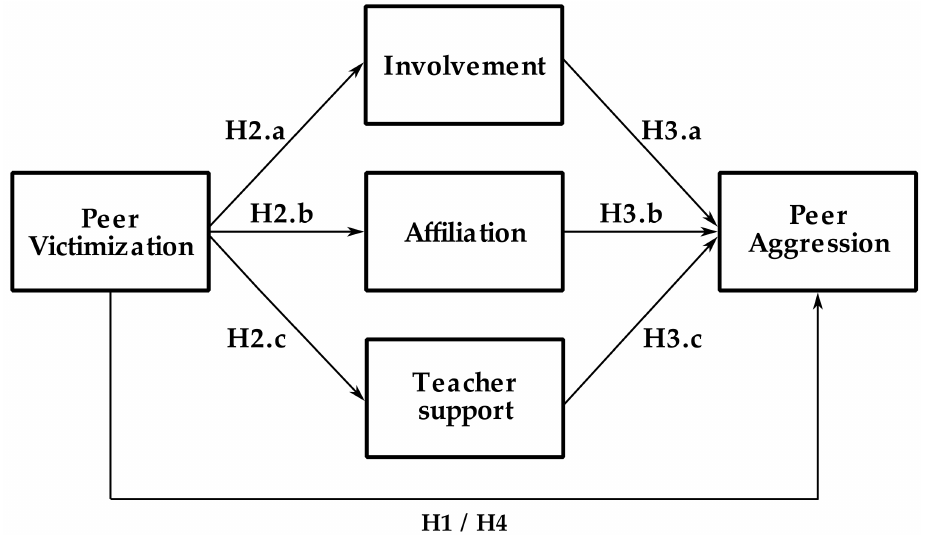
Figure 1. Illustration of the proposed mediation model . Hypothesis 1 (H1). Peer victimization would be positively correlated with peer aggression. Hypothesis 2 (H2). Peer victimization would be negatively correlated with classroom climate. Hypothesis 2a (H2a). Peer victimization would be negatively correlated with the involvement dimension of classroom climate.